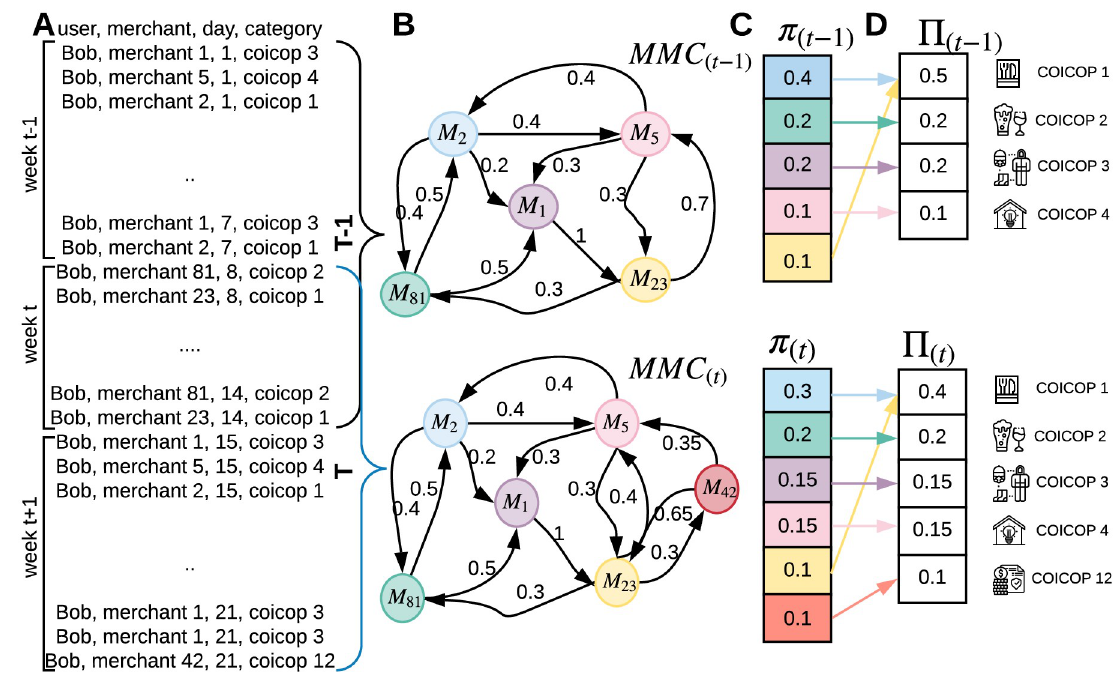
Fig 11. Individual stationary purchasing behavior